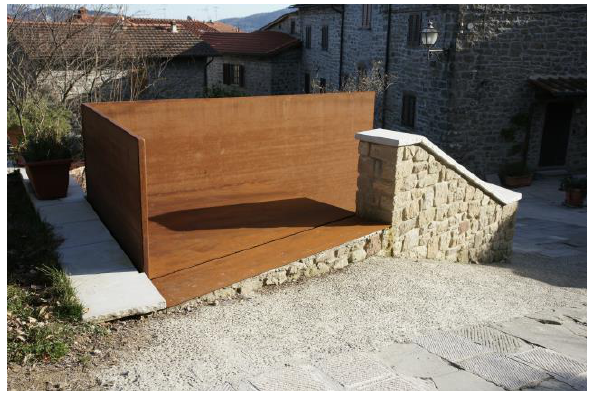
Figure 14. The finished little artifact.